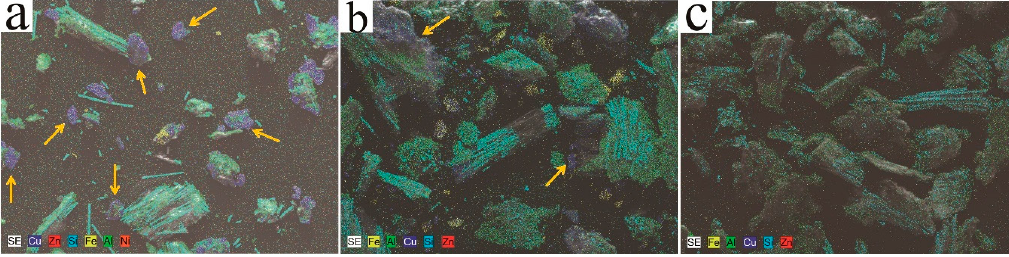
Figure 10. SEM and EDS map analysis of WPCBs ( a ) before bioleaching; WPCB surface morphology for residues ( b ) after bioleaching and ( c ) containing 2.5 g/L graphite under bioleaching condition.